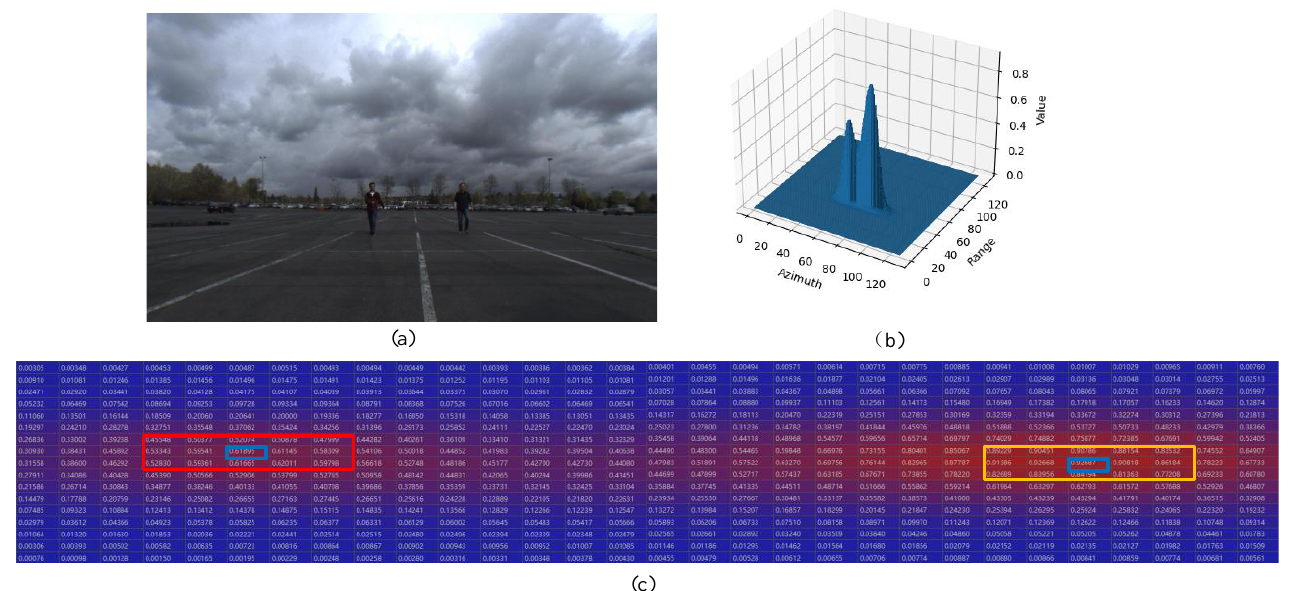
Figure 9. Case (2) data. ( a ) Optical photo of case (2). ( b ) A 2D ConfMap of case (2). ( c ) A 3D ConfMap of case (2). The red and yellow box in ( c ) represents a 3 × 5 slider, and the blue box represents the result of the primary screening peak.